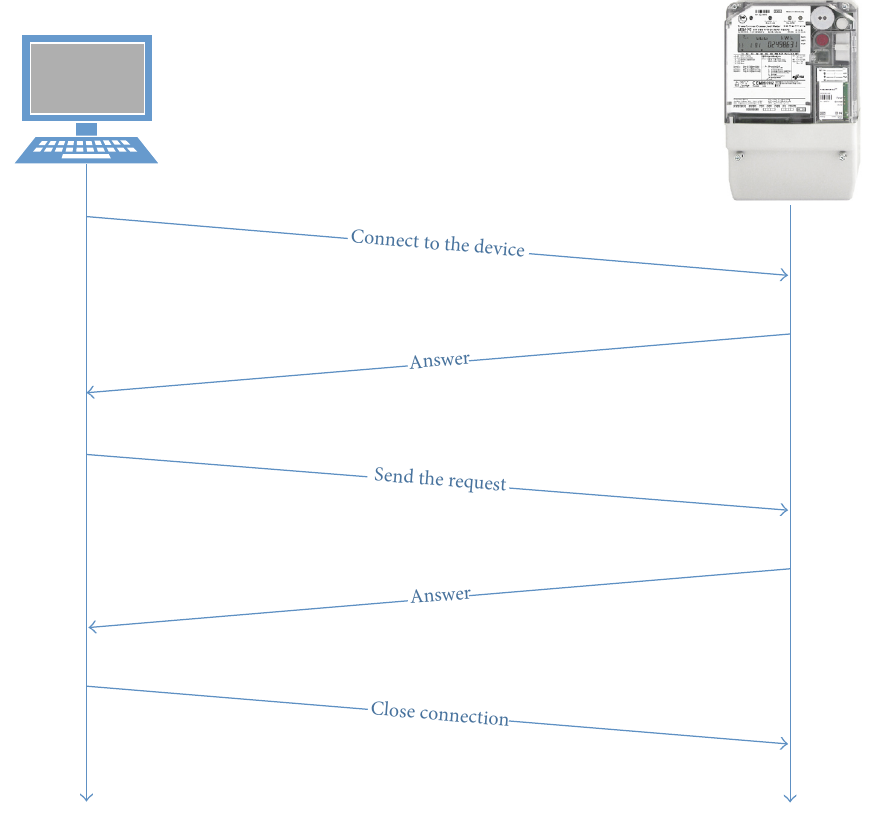
Figure 7: Smart-meter communication